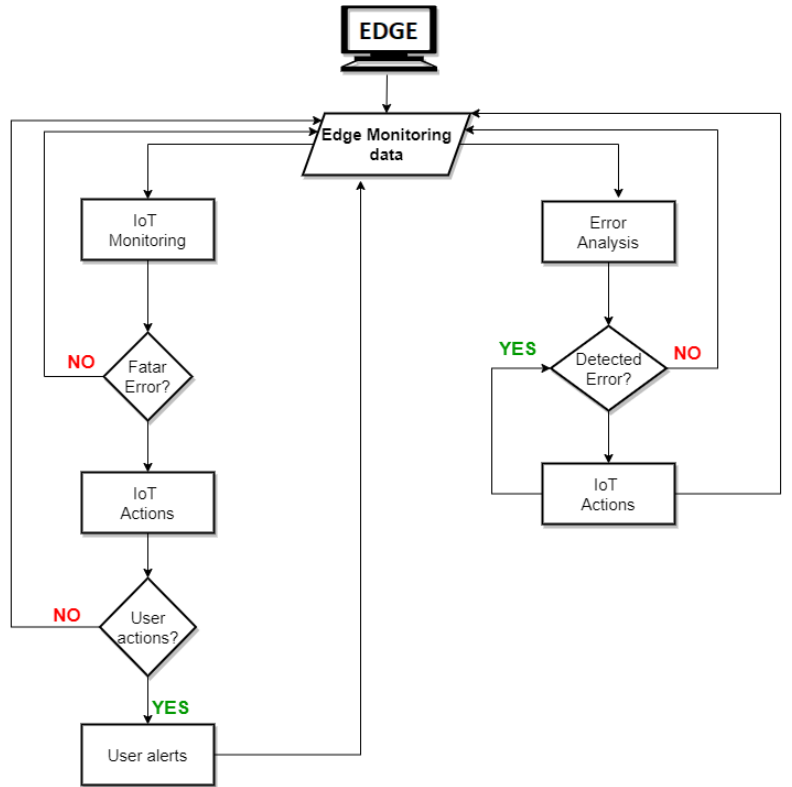
Figure 7. Application layer